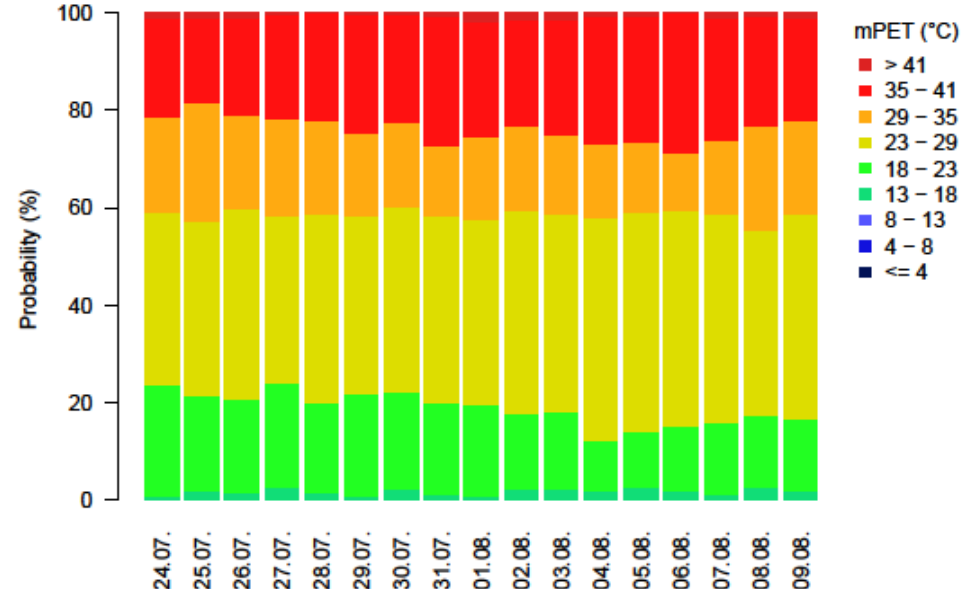
Figure 6. Frequency diagram showing the average occurrence of mPET classes for Tokyo for individual days in the range of the 24th of July and the 9th of August based on data of the years 1966 to 2018. The classes meet the thermal sensation classes stated in Table 2.